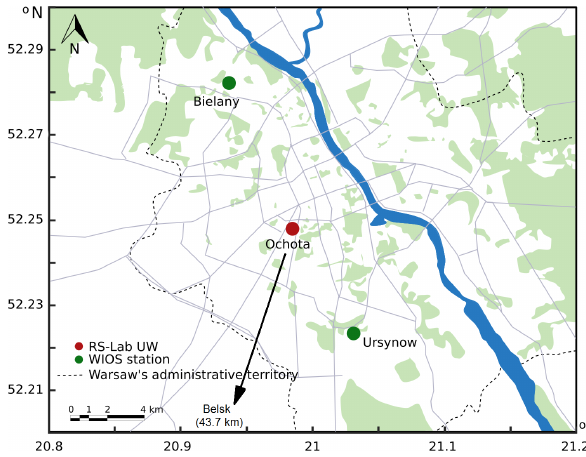
Figure 1. The location of the Remote Sensing Laboratory (RS-Lab) at UW Ochota Campus in Warsaw, Poland (in red), the WIOS mon- itoring stations in Ursynow and Bielany (in green), and the Institute of Geophysics at the Polish Academy of Sciences (IGF-PAS) Ob- servatory in Belsk